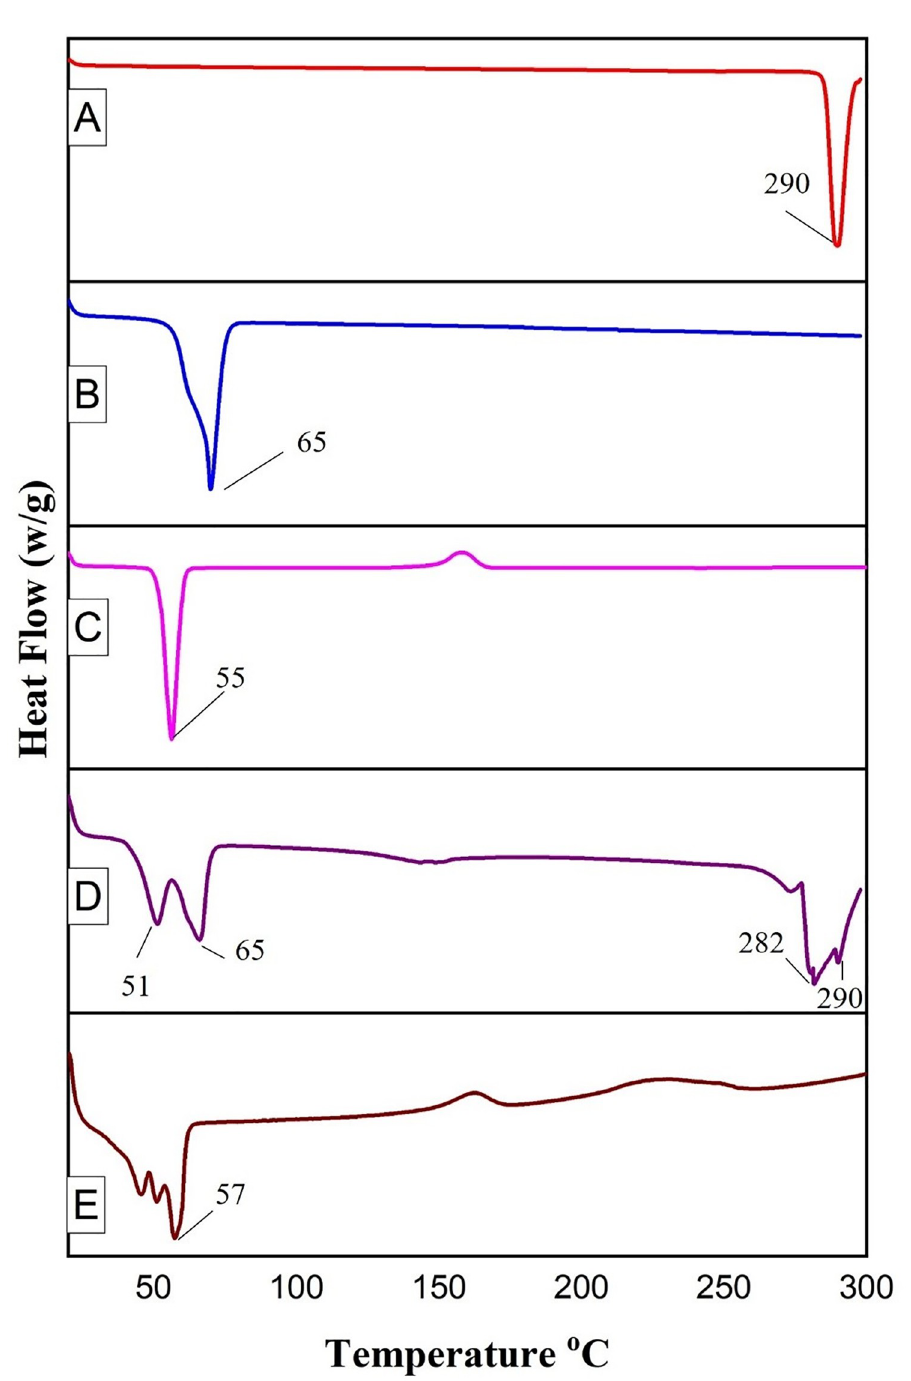
Fig 4. DSC analysis of 5-FU (A), Precirol 1 ATO5 (B), Poloxamer 188 (C), Physical mixture (D), and optimized formulation (E).